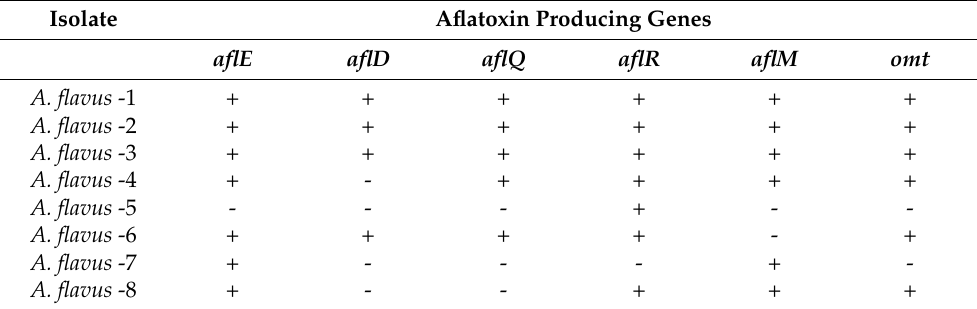
Table 5. Molecular characterization of aflatoxigenic and non-aflatoxigenic strains from the